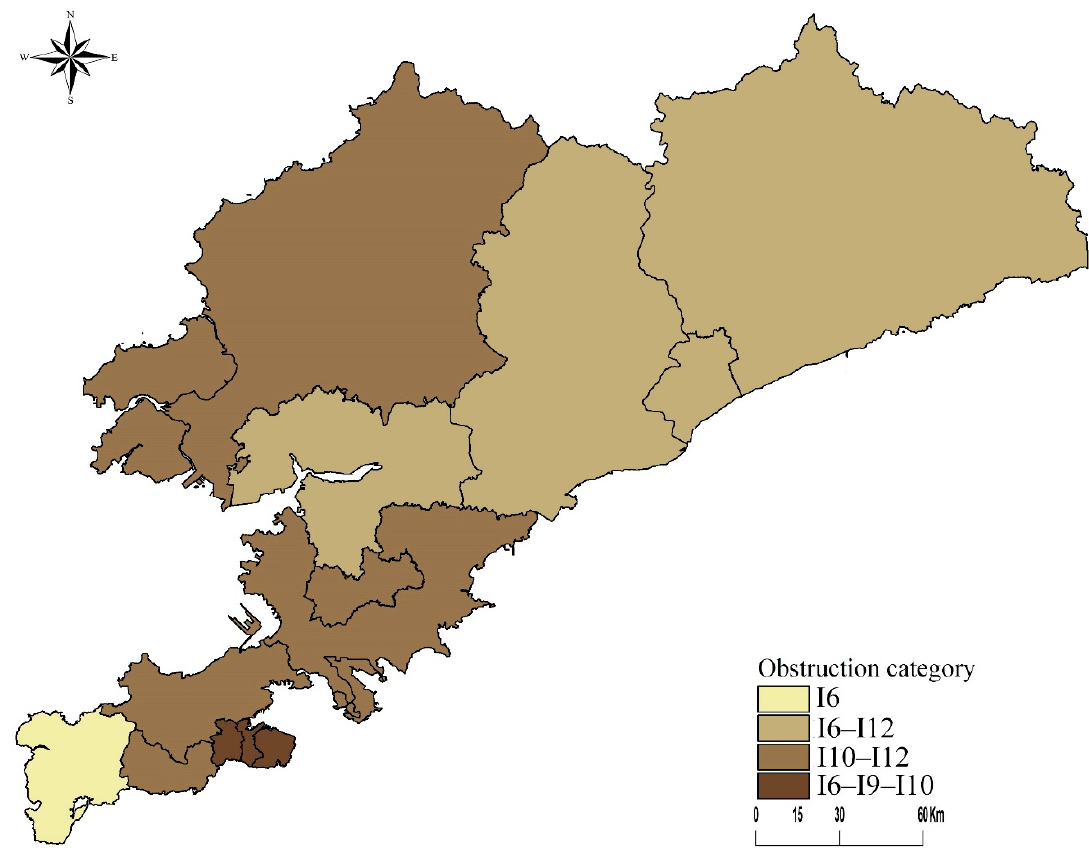
Figure 4. Different types of obstacles in medical undertakings by region. Figure 4. Di ff erent types of obstacles in medical undertakings by